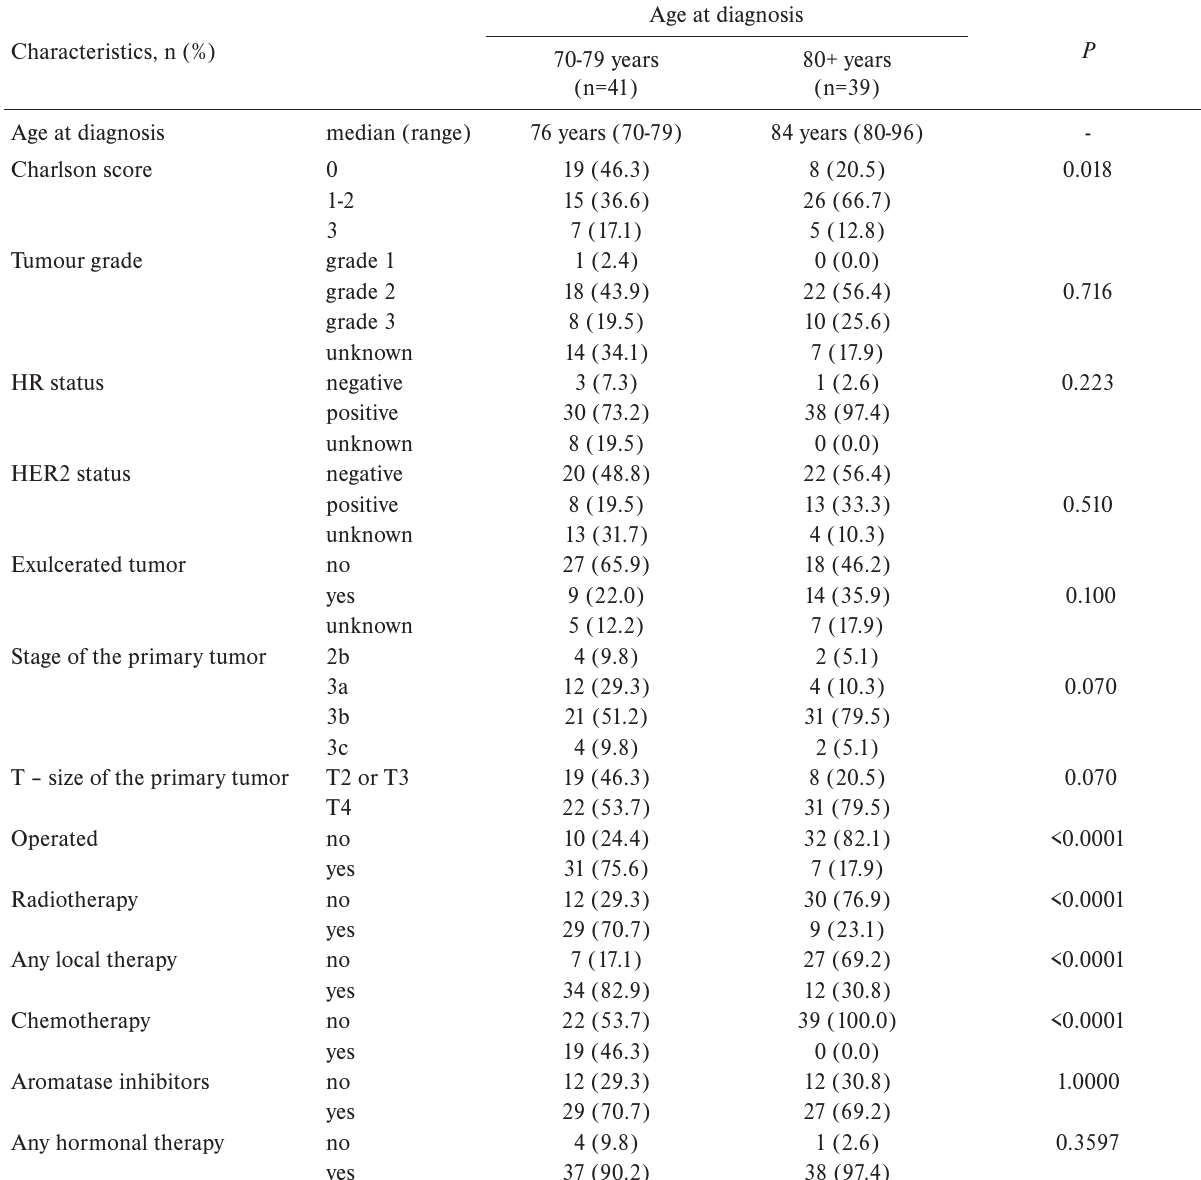
Table 2. Baseline patient